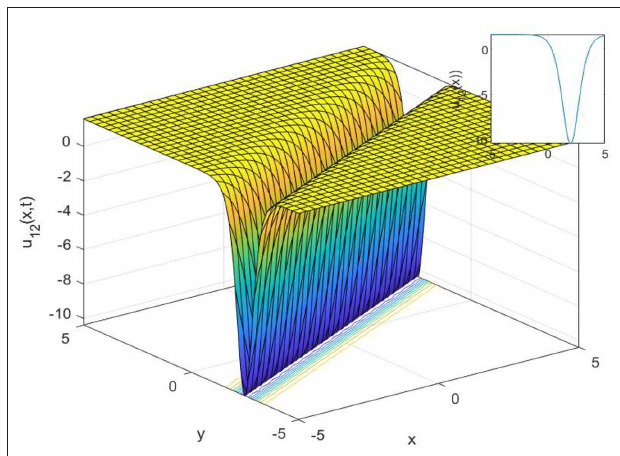
FIGURE 12 | The 3D, 2D, and contour surfaces of Equation (45) using k 3, α 5, and h = = =